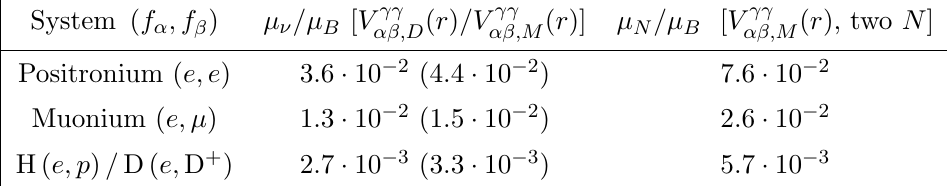
( r ) and V (cid:13)(cid:13) ( r ) compared to the SM potential V LL ee ee ( r ) between the electron and positron. ee